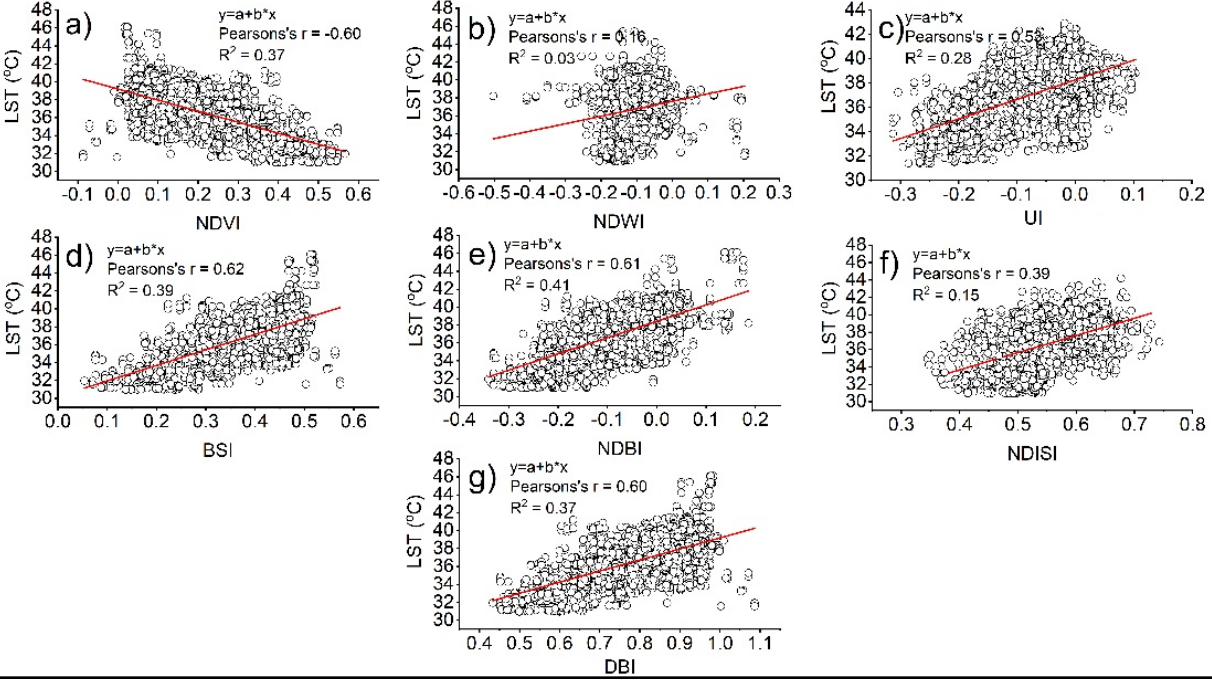
Figure 7. Relationship between LST and LULC indices in transect IV ( a ) NDVI, ( b ) NDWI, ( c ) UI, ( d ) BSI, ( e ) NDBI, ( f ) NDISI, ( g ) Table 6. The multiple linear regression (MLR) between LST and LULC indices.